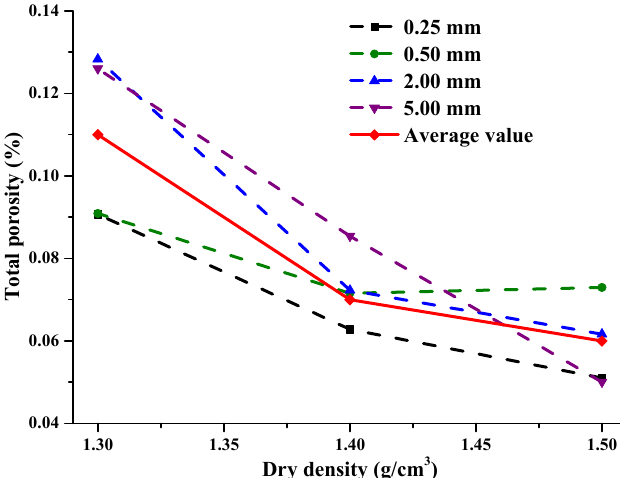
Figure 19. The fitting curve of dry density and total porosity.